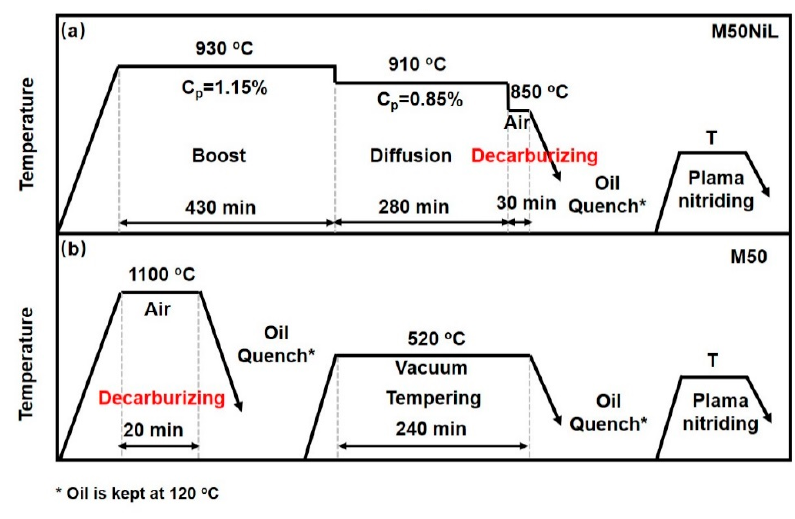
Figure 1. Schematic diagram of duplex process for ( a ) M50NiL steel, ( b ) M50 steel.